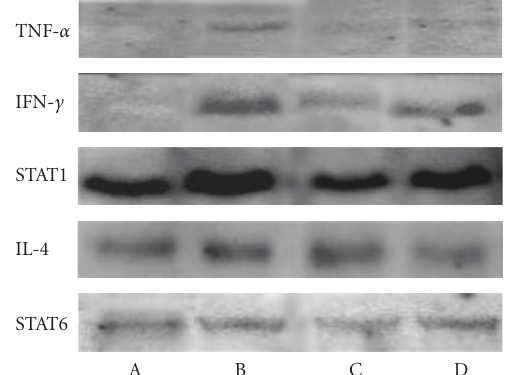
Figure 2: Changes of expression of cytokines in spleen of mice. (A) fed commercial diet, (B) Fed commercial diet + induced colitis by DSS, (C) administrated IO, and (D) administrated IO + induced colitis by DSS ( n = 7 for each group).